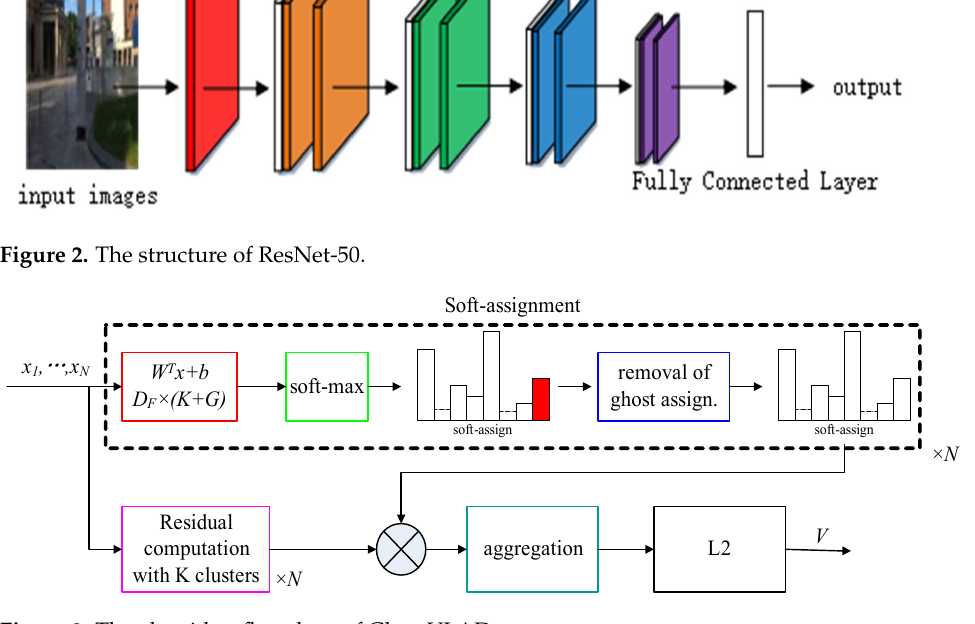
Figure 3. The algorithm flowchart of GhostVLAD. The input of the ResNet model is the color image of the real scene, and the image size is 224 × 224 × 3. The last mean pooling layer and full connection layer of ResNet ‐ 50